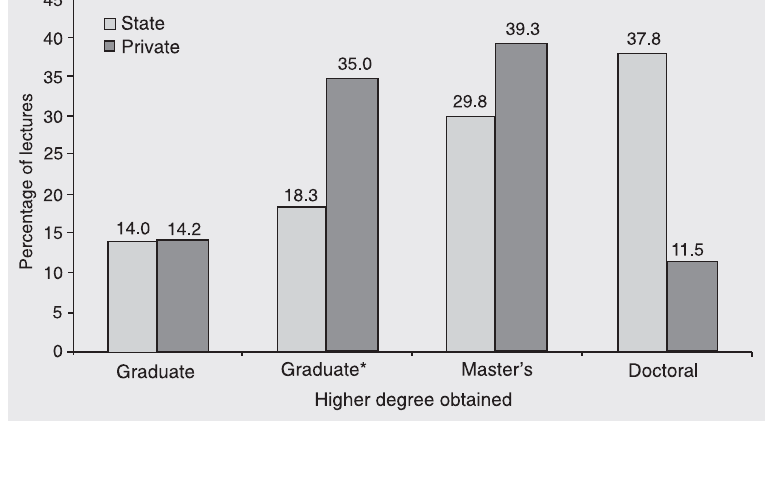
Figure 13. Percentage of lecturers employed at state and private universities as a function of work regimen, including full-time, part-time or “per hour” schedules, calculated based on data available in June 2003 (origi- nal data source: INEP,